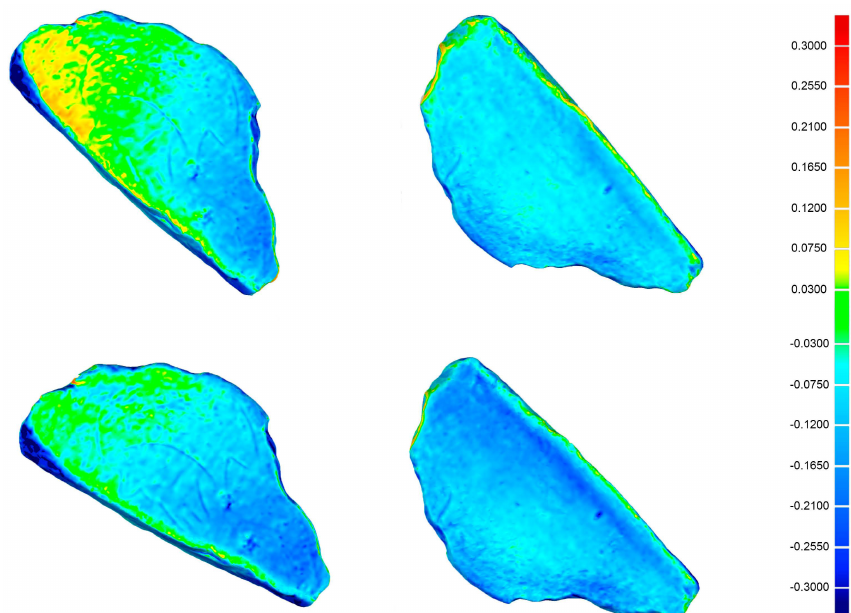
Figure 8. Results of the comparison between the original data and its colored replica. ( above ) the first test (the original data and the first survey of the copy); ( below ) the second one (original data and the second survey). Di ff erences are in